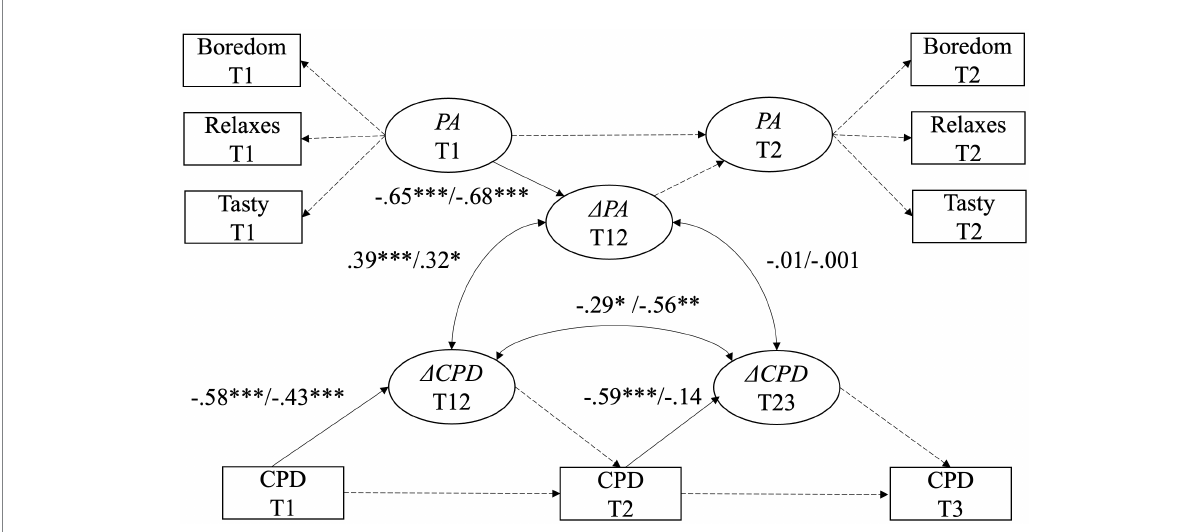
FIGURE 2 Latent change score model for changes in positive attitudes (PA) and its associations with changes in cigarettes smoked per day (CPD) between pre- (T1), post- (T2), and follow-up (T3) assessment. Auto-correlations between indicators, restrictions for variances and intercepts are not represented. Standardized estimates are displayed. Δ symbolizes latent change scores. All effects for Turkish-speaking people are displayed first, effects for Albanian-speaking people second. † p = 0.10, * p < 0.05, ** p < 0.01, *** p <